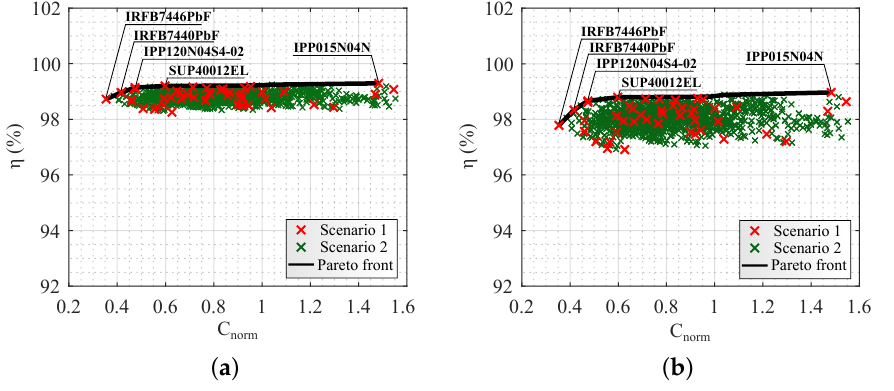
Figure 9. Pareto front for PS. ( a ) 500 W. ( b ) 800